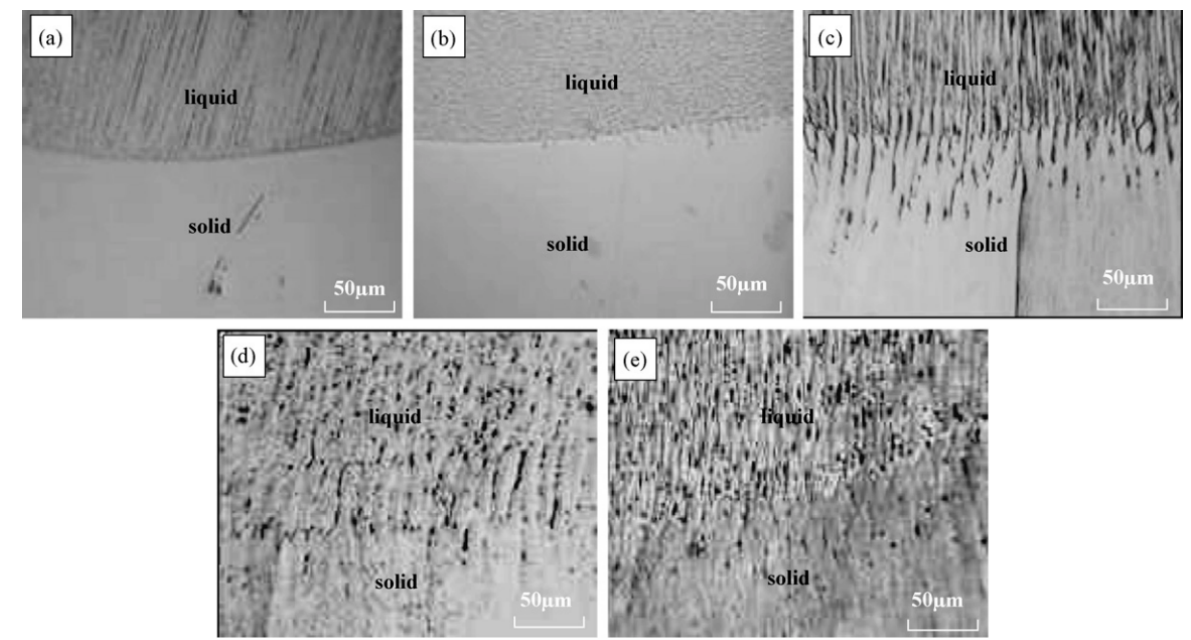
Figure 20. Microstructure at the pulling rate of 12 μ m/ с with different magnetic intensity: ( a ) 0 T,